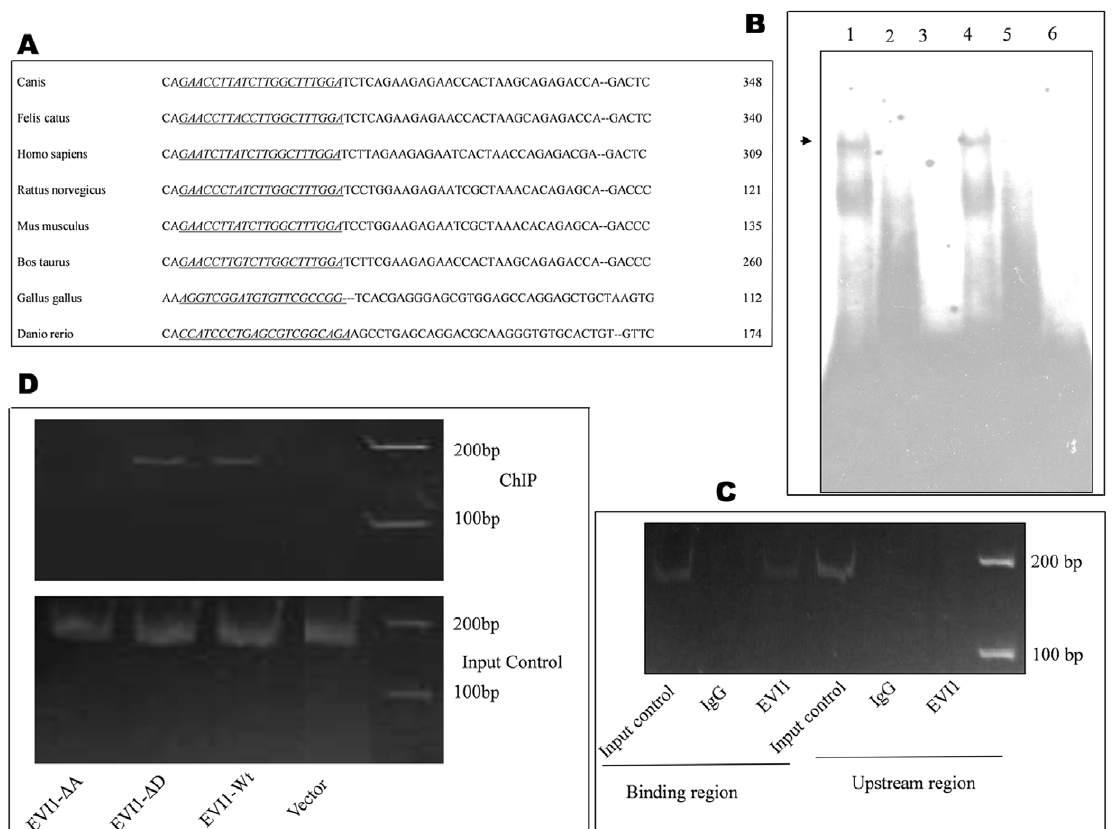
Figure 1. EVI1 binds to Bcl-xL promoter element. A. A multiple sequence alignment of parts of Bcl-xL 2 nd exon from different species are shown and the binding site is underlined. Genbank accession numbers of each of Bcl-xL sequence from different species that were used in the alignment analysis are as follows, Canis familiaris : NM_001003072.1, Homo sapiens : NM_138578.1, Rattus rattus : NM_001033670.1, Gallus gallus : NM_001025304.1, Danio rerio : NM_131807.1, Felis catus : NM_001009228.1, Bos taurus : NM_001077486.2 and Mus musculus : NM_009743.4. B. Nuclear extracts from EVI1 transfected 293T cells were incubated with a radiolabelled, double-stranded oligo designed from the EVI1 binding site in Bcl-xL promoter. EVI1 binds to Bcl-xL (lane 1) as shown by an arrow whereas a mutated probe failed to show any binding (lane 2). Lane 3 shows only the empty vector transfected cells and lane 6 shows the probe without any nuclear lysate. Increasing amount of specific cold competitor at 30 6 molar excess of radiolabelled probe (lane 4) failed to inhibit the binding of EVI1 to Bcl-xL promoter however a cold competitor at 50 6 molar excess of radiolabelled probe (lane 5) inhibited binding of EVI1 to Bcl-xL promoter. C. ChIP analysis shows the occupancy of EVI1 on the Bcl-xL promoter in vivo . After cross linking and chromatin fractionations DNA protein complexes were incubated with EVI1 antibody and the complex were processed as per the manufacturer’s instructions (Imgenex India Pvt. Ltd.). Eluted DNA samples were then analyzed by PCR using specific primers flanking the EVI1 binding region. A band of 170 bp was observed only in HT-29 cells (lane 3) and no band was observed with IgG (lane 2) or with primers taken from the upstream region (lane 6). Marker (M) and the input controls for both regions are as shown (lane 1 and lane 4). D. ChIP was performed on 293T cells transfected with empty vector or EVI1 construct. For this assay flag-CMV-vector, flag-EVI1 wild type (Wt), flag- EVI1- D A (EVI1- D 24 to 239) and flag-EVI1- D D (EVI1- D 735 to 812) constructs were transfected separately in 293T cells. After processing as described above PCR showed an amplification of 170 bp when cells were transfected with EVI1 and EVI1- D D where as no amplification was observed in vector transfected cells or EVI1- D A transfected cells. Marker and the input control are as shown.